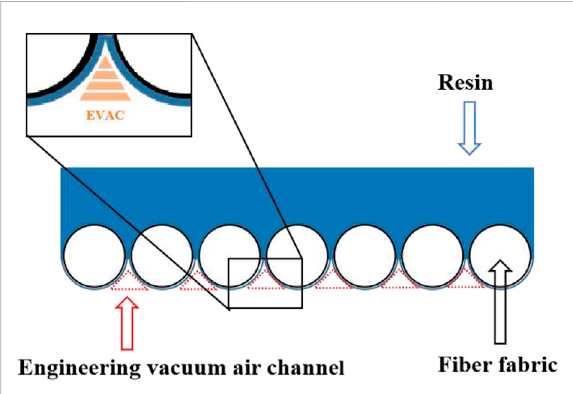
FIGURE 1 Schematic diagram of asymmetric impregnation of the